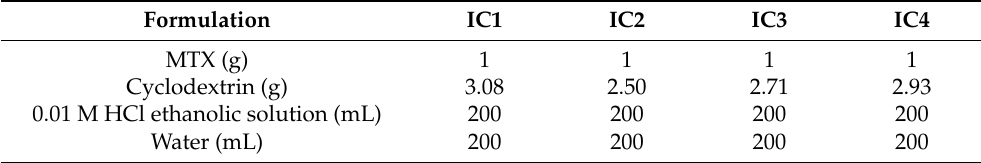
Table 1. Composition of various inclusion compounds; MTX/HP- β -CD inclusion complex (IC1); MTX/ β -CD inclusion complex (IC2); MTX/M- β -CD inclusion complex (IC3); MTX/DM- β -CD inclusion complex